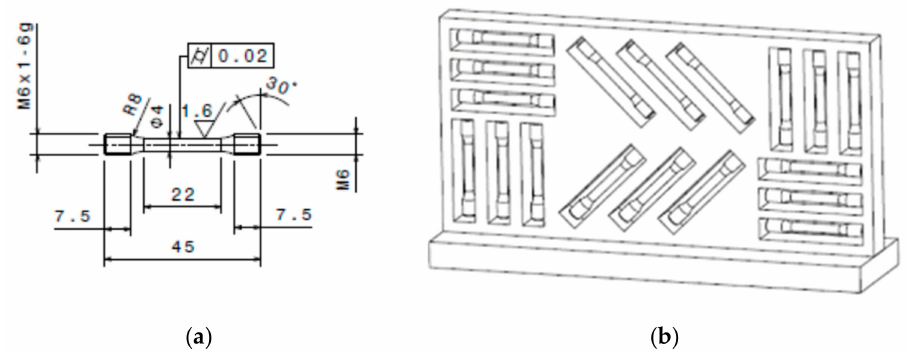
Figure 2. Dimensions of the samples for tensile tests in mm, Rz in µ m, ( a ) and schematic representation of the location of the extracted samples ( b ).